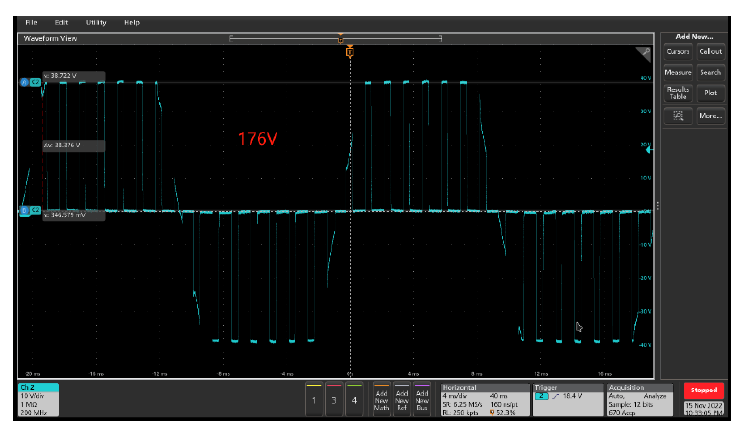
Figure 15. Characteristic current value 2 of practical test waveform.